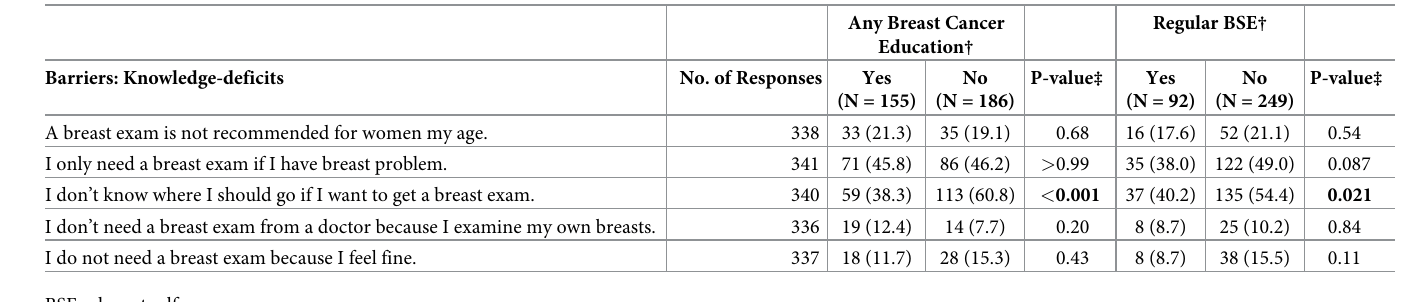
Table 4. Knowledge deficits as barriers to breast cancer education and regular